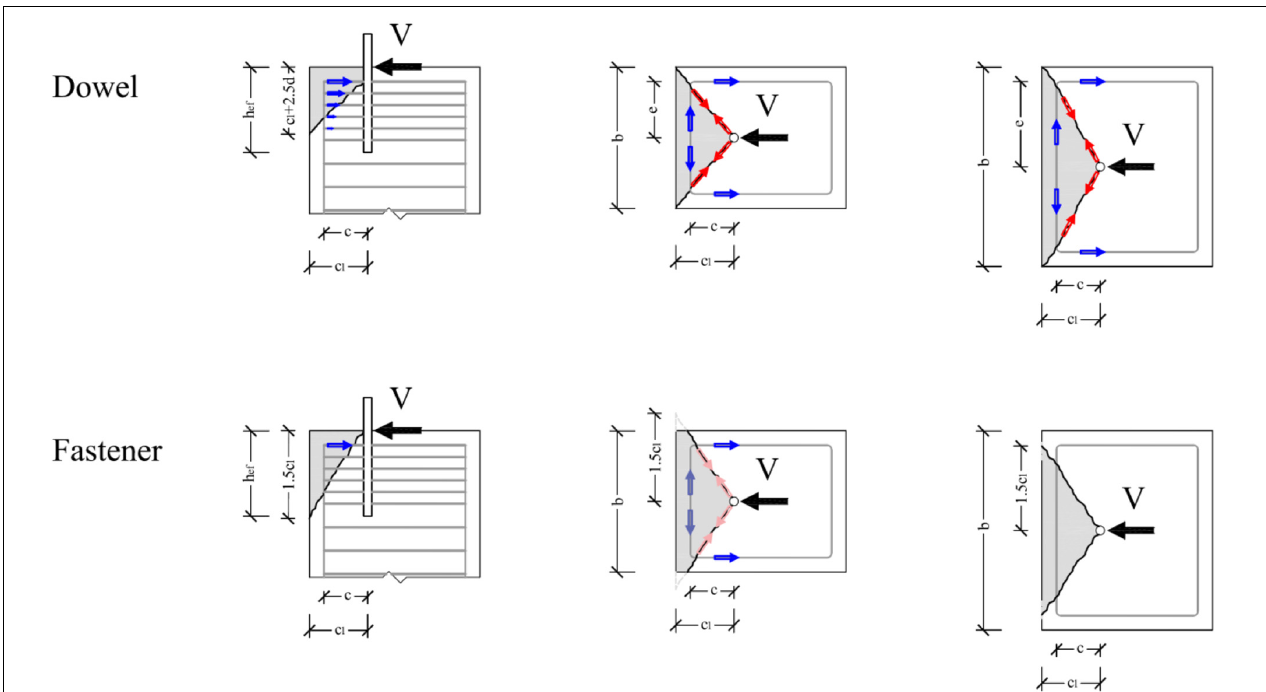
FIGURE 5 | Engagement of reinforcement according to the “dowel” and “fastener” models (blue, tensioned ties; red, compressed struts).